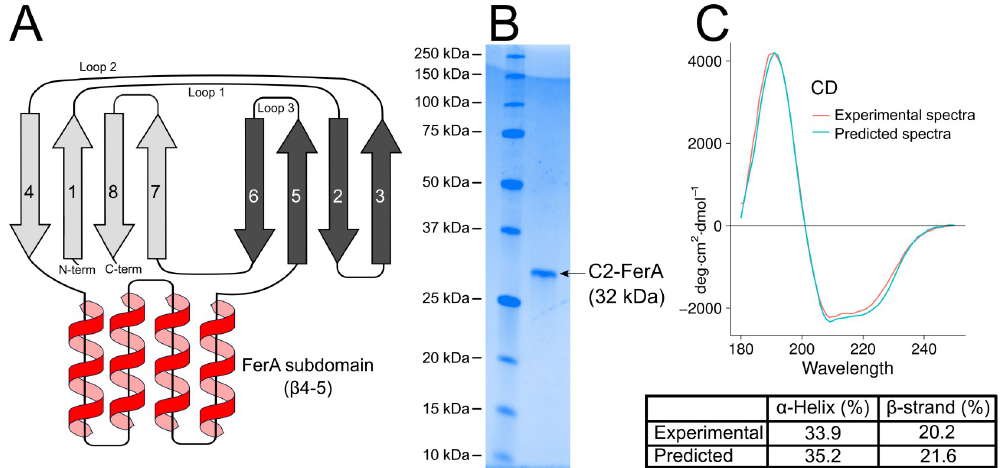
Fig 7. Dysferlin C2-FerA analysis. A. C2-FerA domain schematic showings the secondary structure connectivity and the large insertion of the β 4–5 FerA subdomain. B. SDS-PAGE showing the purified dysferlin C2-FerA domain versus molecular weight size markers. C. Far-UV CD spectrum of purified dysferlin C2-FerA (red curve) and predicted C2-FerA spectrum derived from the model (blue curve). The inset table reports the secondary structure summary of the purified dysferlin C2-FerA domain (Experimental), and the dysferlin C2-FerA model (Predicted).